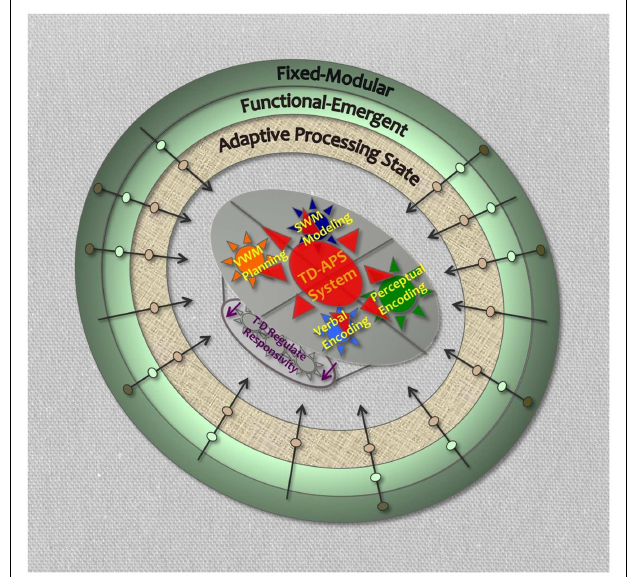
FIGURE 3 |Task-directed-adaptive processing state brain system . Legend: shows four primaryTD-APS brain system computational nodes. Outer rings represent levels of brain function that could impactTD-APS brain system. Arrows crossing outer rings represent hypothetical unique impairment trajectories with causal deficits originating at different levels of brain function. Purple arrows representTD-APS intrinsic regulation of automatic sensory